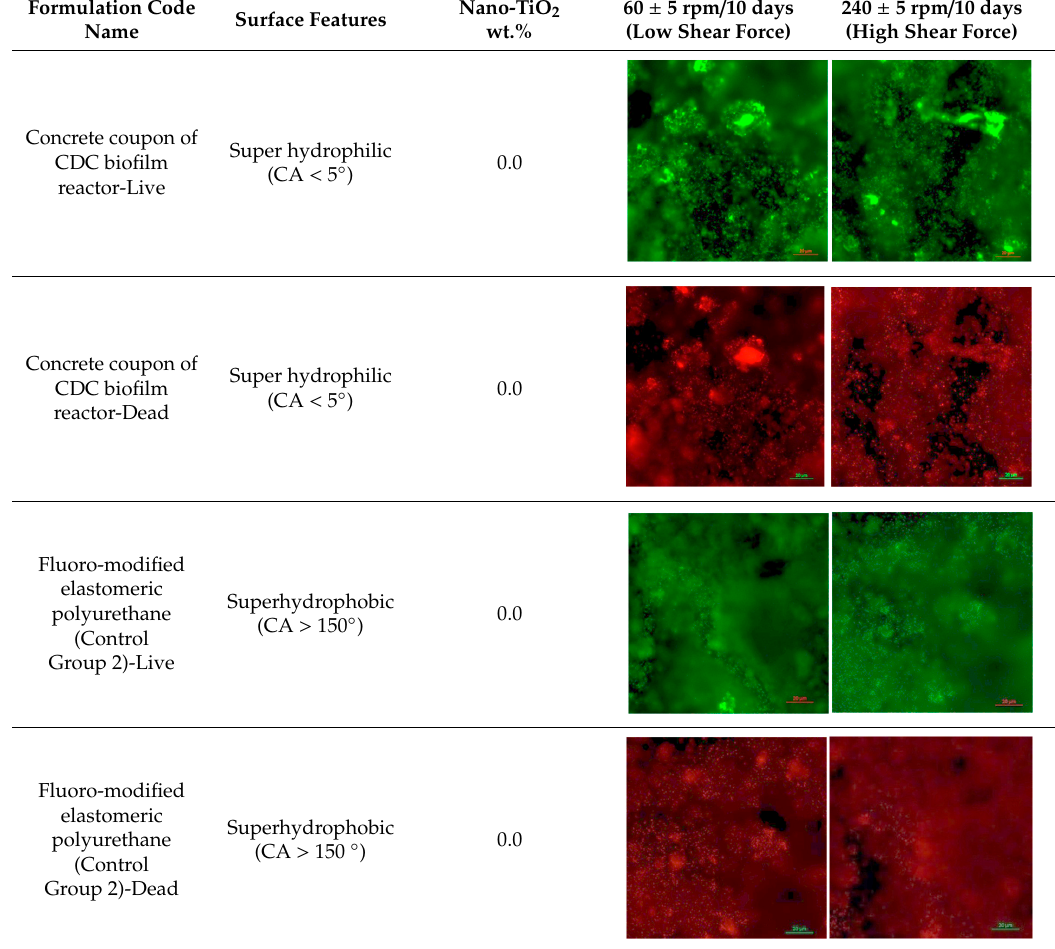
2. Table 5. Live/dead microscopy of control group excluding the effect from nano-TiO